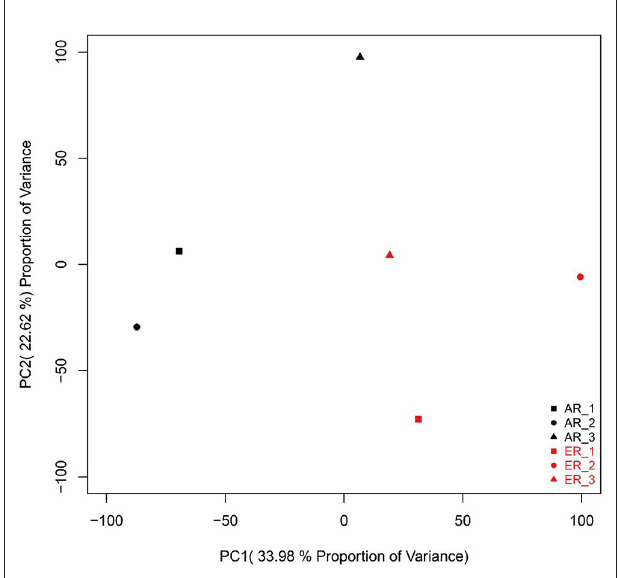
FIGURE 1 | The principal component analysis (PCA) analysis of gene expressions in the intestinal samples. The black patterns represent the artificially reared (AR) group and the red patterns represent the ewe reared (ER) group.